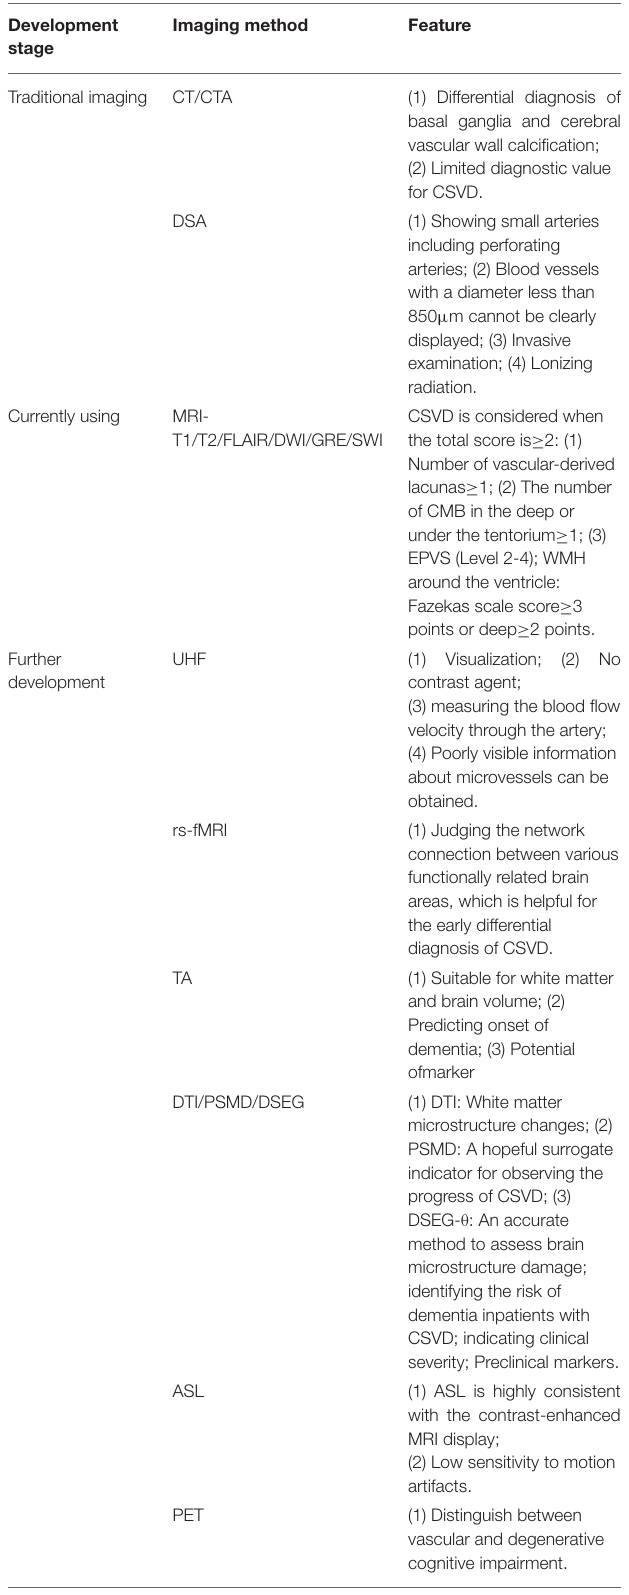
TABLE 1 | Classification of imaging diagnosis of CSVD. Development Imaging stage